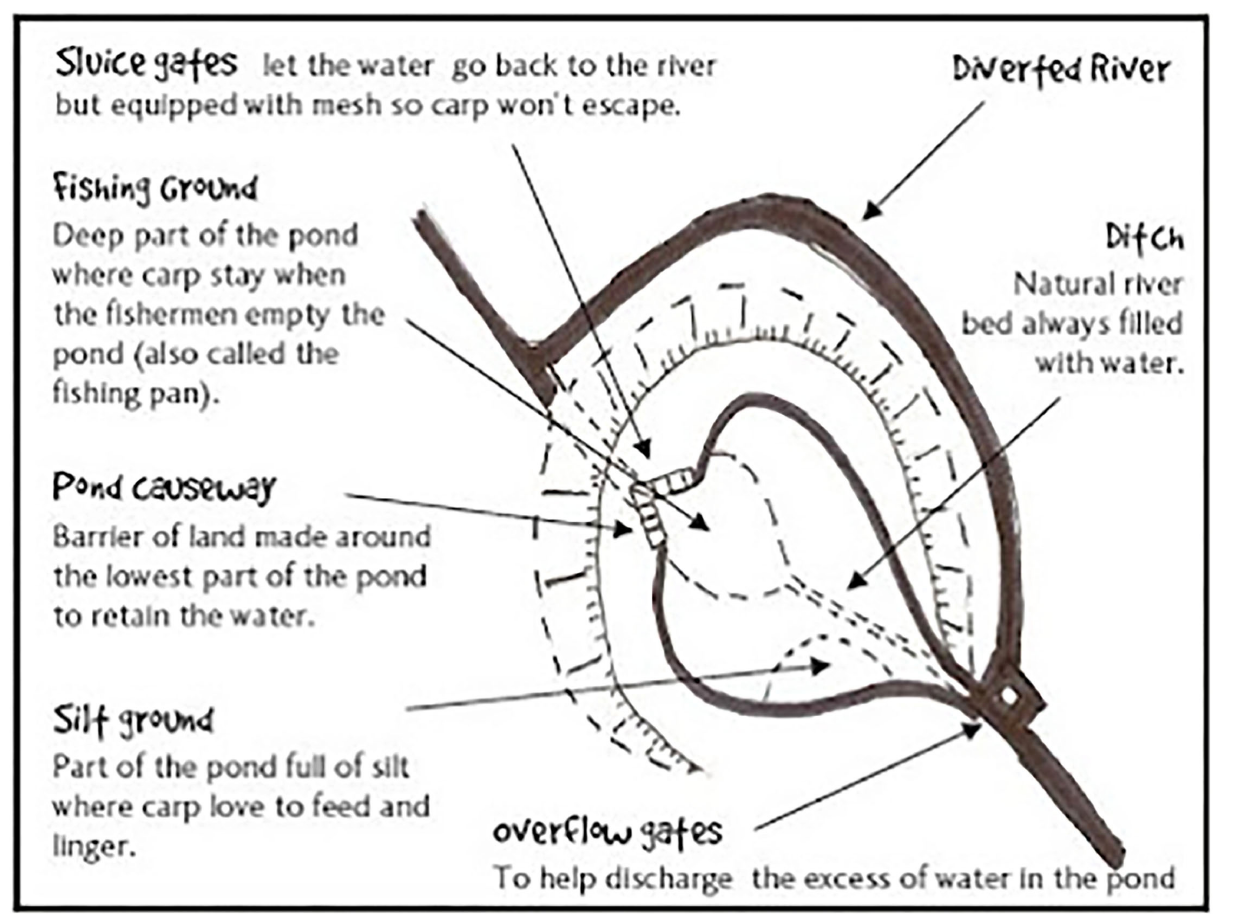
FIGURE 2 | Sophisticated aquaculture engineering of a monastery pond in Medieval Europe reconstructed from archeological investigations. Taken from Moisand (2008)